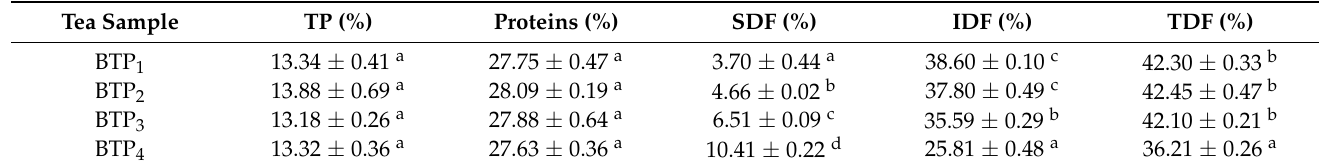
Table 2. Quantitative analyses of the functional compounds of BTPs at different pulverizing